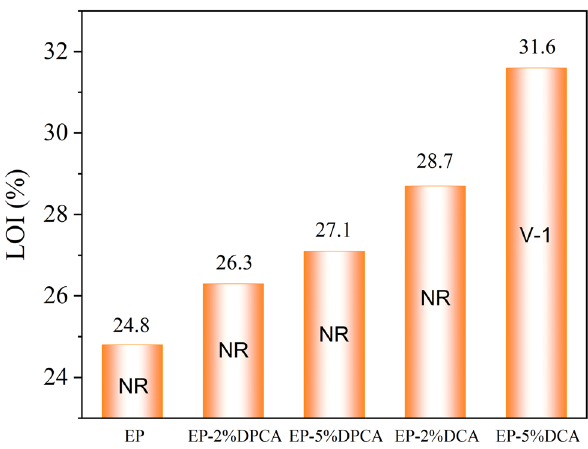
Figure 4: The LOI and UL - 94 results of EP, EP - 2 wt% DPCA, EP - 5 wt% DPCA, EP - 2 wt% DCA, and EP - 5 wt%